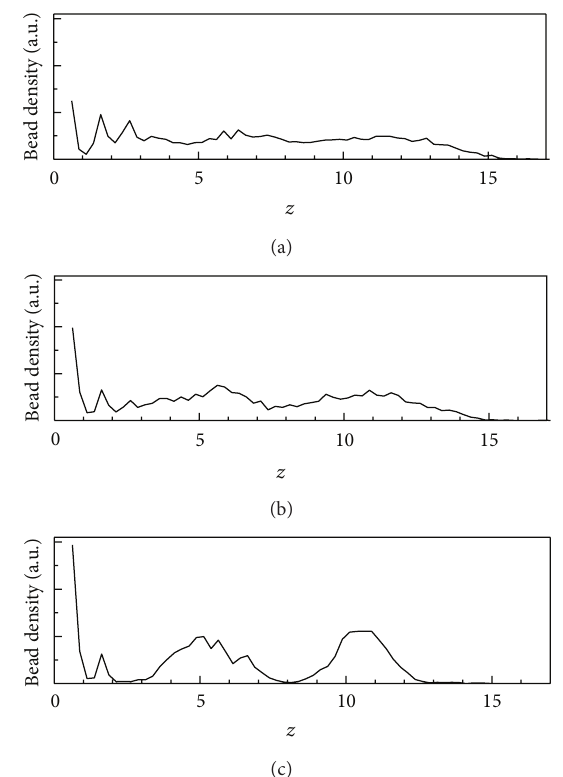
Figure 15: Density profiles of the end beads as a function of the distance from the wall, 𝑧[𝜎] : (a) 𝜀 𝑝 𝑏 = 𝜀 𝑝 𝑤 = 0 and (b) 𝜀 𝑝 𝑏 = 𝜀 𝑝 𝑤 = 𝜀 , and (c) 𝜀 𝑝 𝑏 = 𝜀 𝑝 𝑤 = 2𝜀